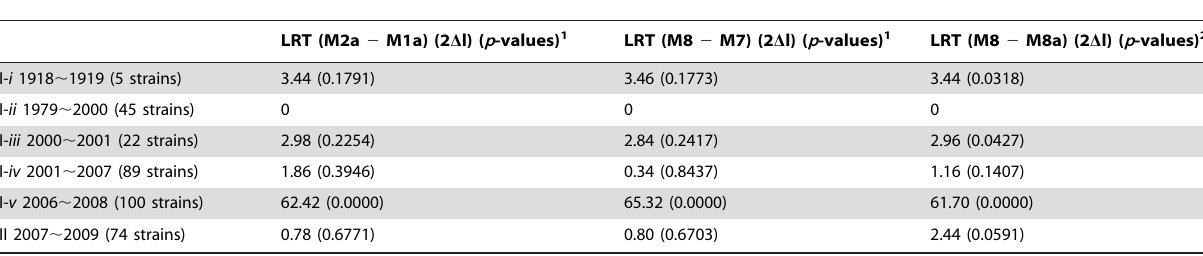
Table 2. LRT tests for HA 1 sequences of human A(H1N1) influenza viruses.